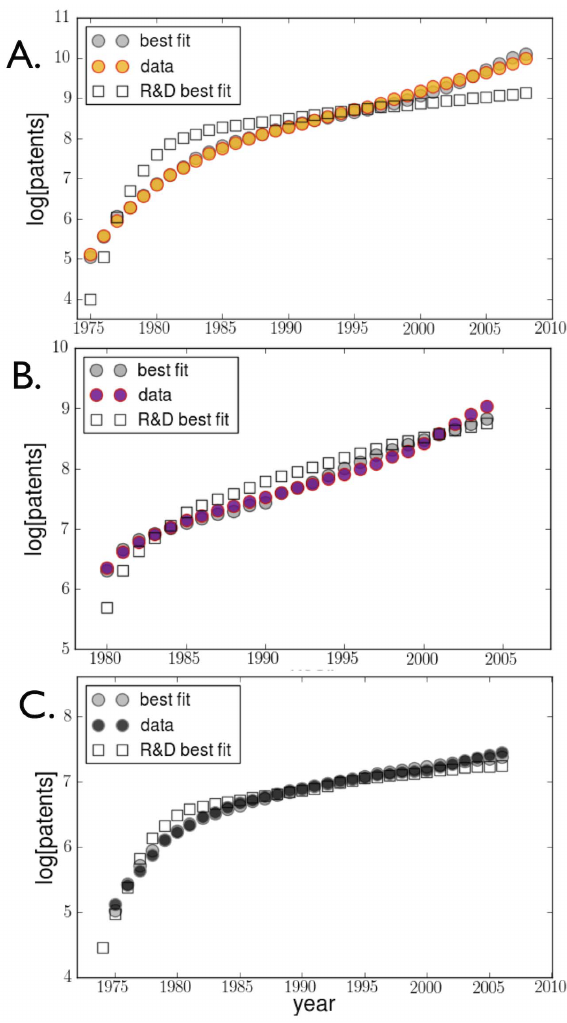
Figure 4. Patenting growth, R&D investment and market expansion for (A.) Solar (photovoltaic) worldwide, (B.) Wind worldwide and (C.) Coal, US only. Innovation, proxied by (cumulative) patent applications, is well described (grey dots) by a production function that includes both the effects of cumulative production and cumulative public R&D investment for all technologies. This relationship holds at various stages of maturity. A restricted Eq. (1) accounting for public R&D investments alone gives a poor description of the trends observed (open squares), failing in particular to account for the uptick in patenting (and upwards curvature) in wind and solar technologies over the last decade. Full details of the fit parameters and statistical goodness of fit are given in the SI. The best fit for solar has a =0.22, b =0.41, R 2 ~ 0 : 997 and p-values , e { 9 . The best fit for wind has a =0.51, b =0.30, R 2 ~ 0 : 983 and corresponding p-values ~ 7 : 9 e { 5 and 1 : 4 e { 9 , respectively. The best fit for coal has a =0.18, b =0.43, R 2 ~ 0 : 997 and p-values , e { 12 .